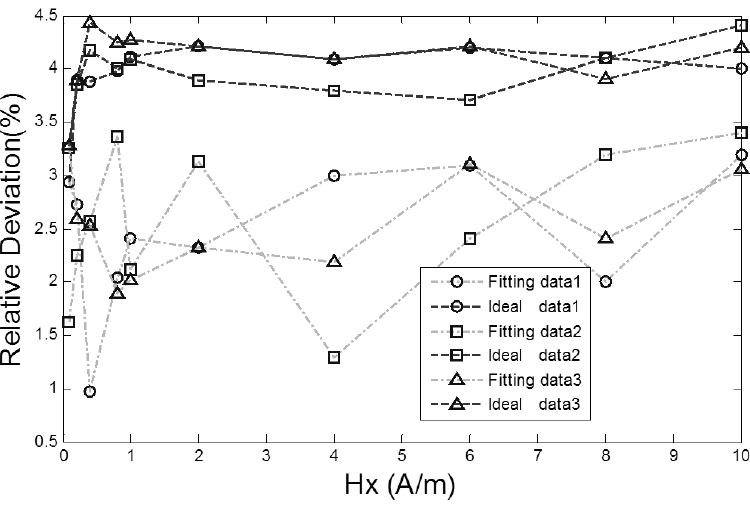
Figure 10. The relative deviation contrast curves between the output time D-values of the RTD-fluxgate under two different conditions s and the actual